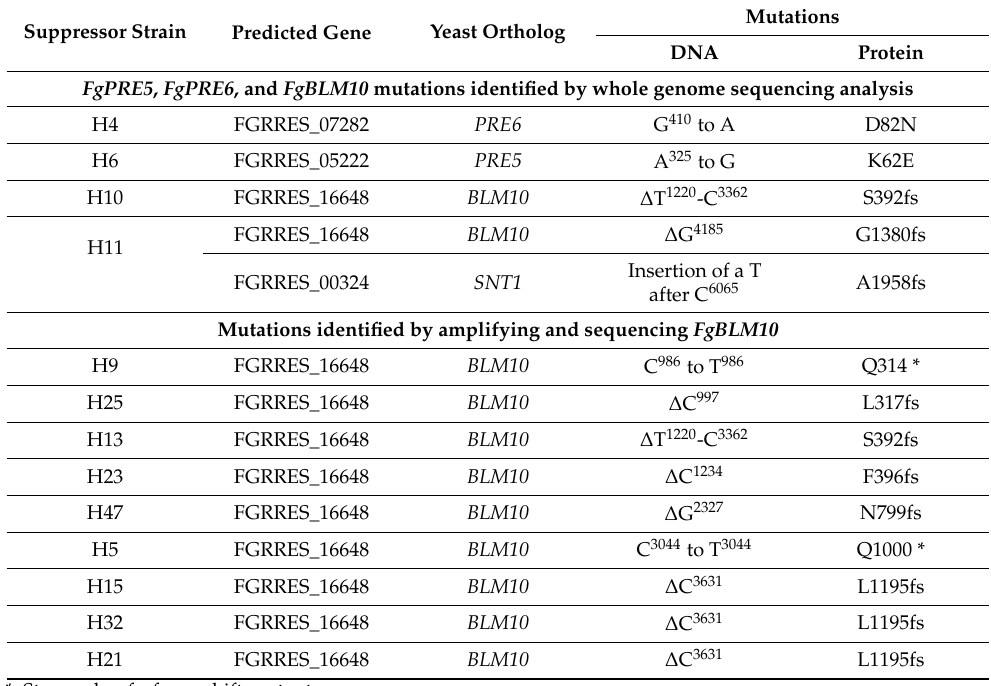
Table 1. Mutations identified in the ORFs of predicted genes in suppressors of pkr . Suppressor Strain Predicted Gene Yeast Ortholog